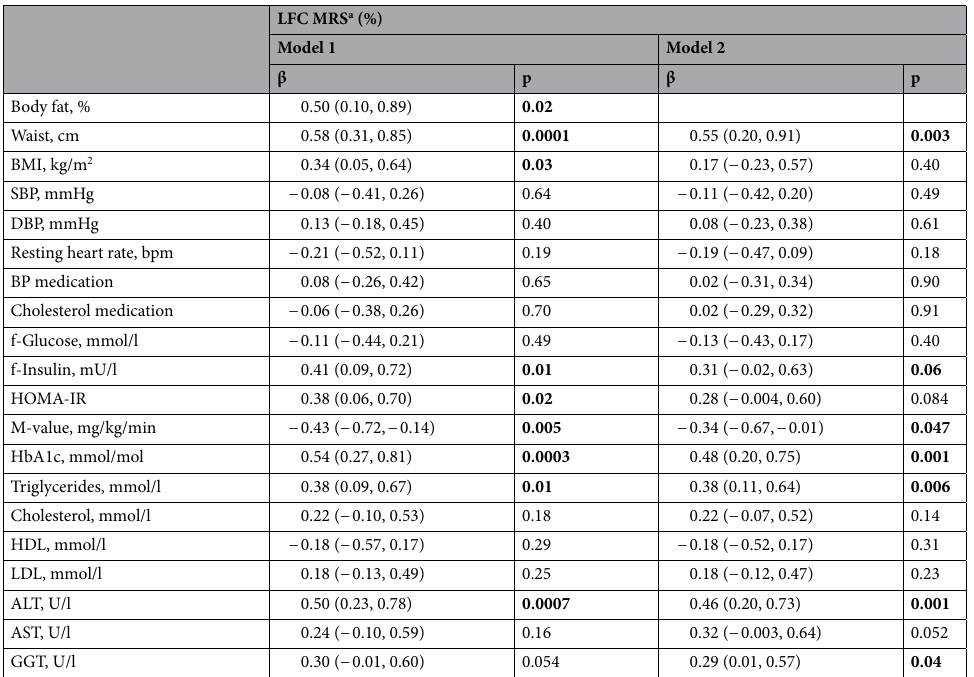
Table 6. Age-, sex- and body fat %-adjusted linear mixed regression estimates (standardized β coefficients (95% CI)) between MRS-measured LFC, body composition and cardiometabolic risk factors. Model 1 adjusted for age and sex. Model 2 adjusted for age, sex and body fat % ALT alanine aminotransferase, AST aspartate aminotransferase, BP blood pressure, DBP diastolic blood pressure, f fasting, GGT γ-glutamyltransferase, HbA 1c hemoglobin A 1c , HOMA‑IR homeostatic model assessment for insulin resistance, LFC liver fat content, MRS magnetic resonance spectroscopy, M‑value whole-body insulin sensitivity, SBP systolic blood pressure. a log10 transformed variables. Significant values are in